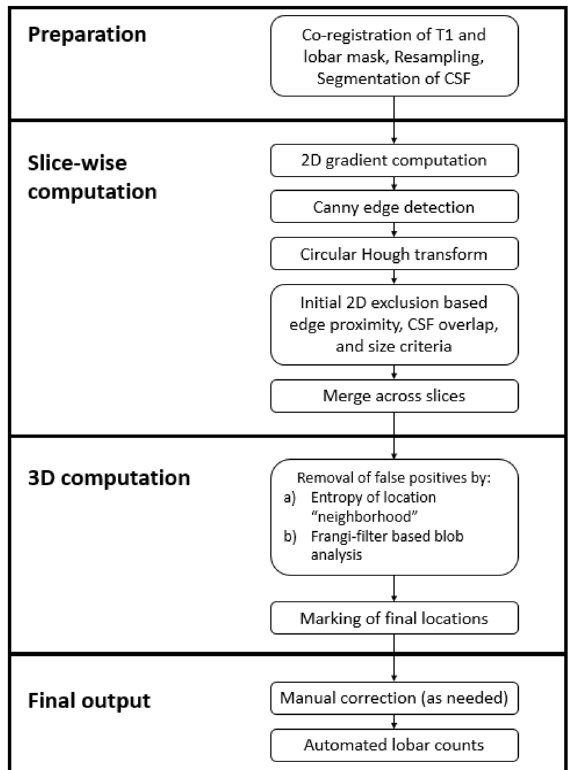
Figure 2. Algorithm flowchart. Summary of the algorithm as described in the